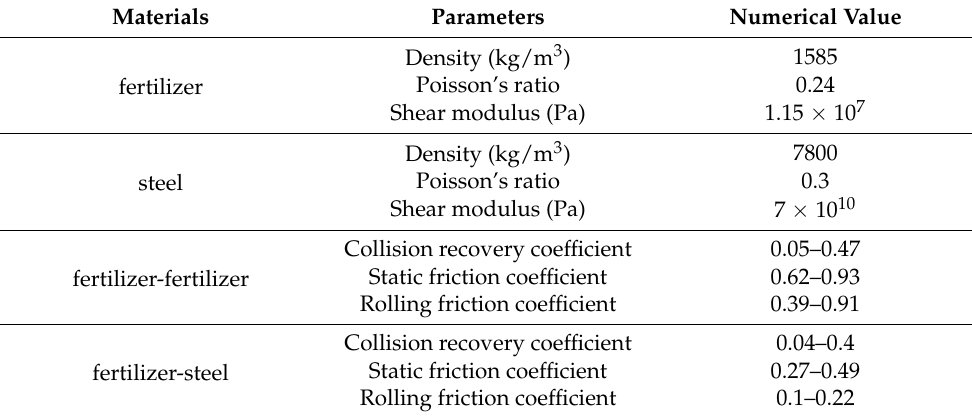
Table 1. Simulation parameters of discrete element.